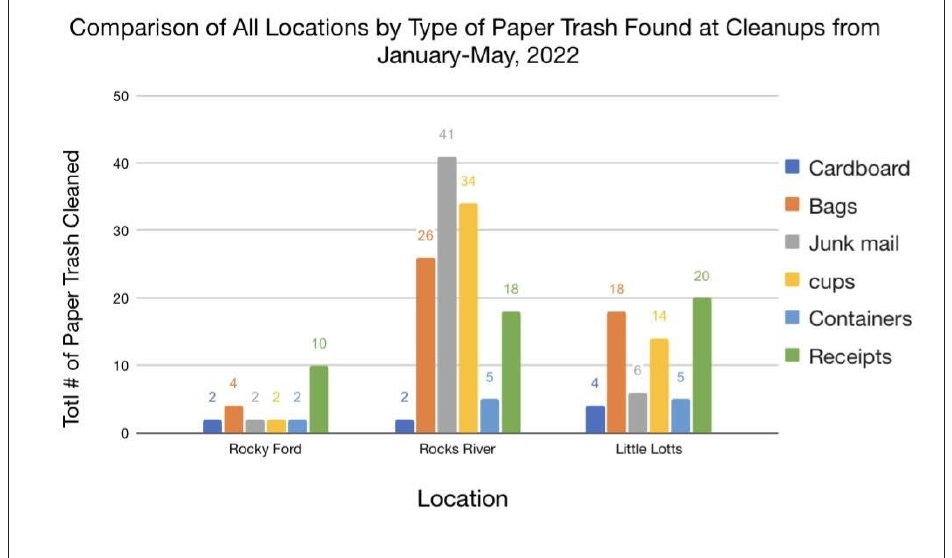
Figure 14. Trash Analysis — Paper Products Found During Cleanups.